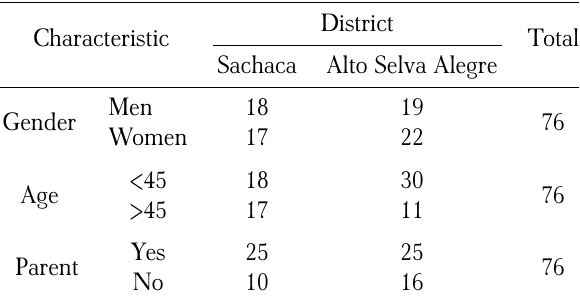
Table 1: Demographics of the interviewees.